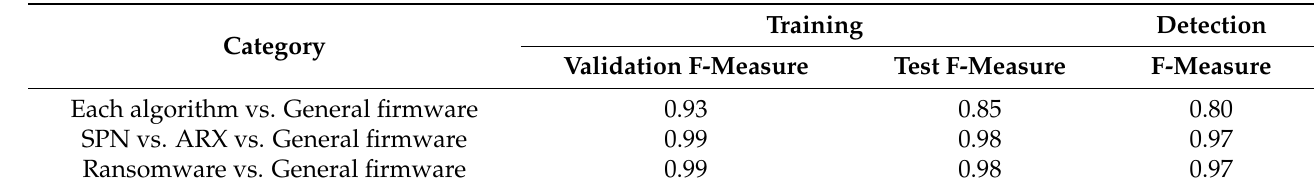
Table 4. Evaluation of opcode-based